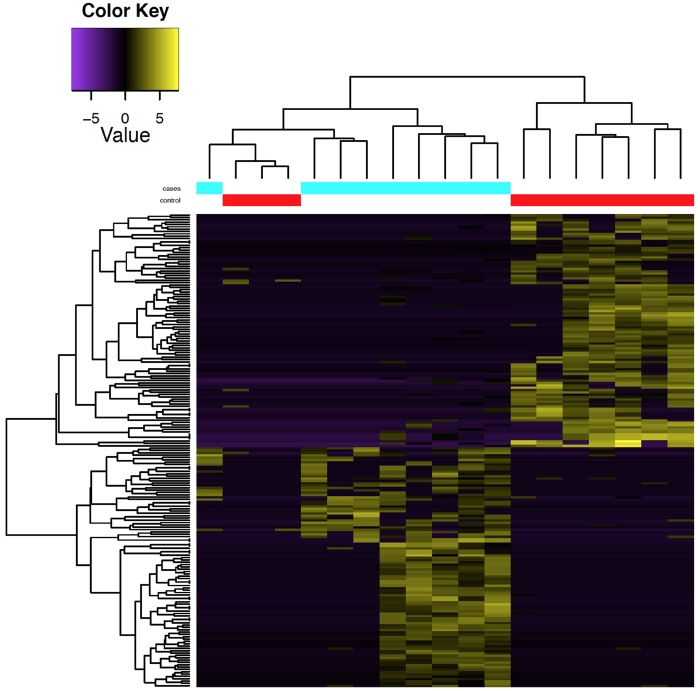
TE transcriptome in the DLPFC of Schizophrenia patients. The heatmap presents the pattern of the 112 up- and down-regulated TEs with Fold Change ± 4 comparing schizophrenic patients with controls. The vertical tree shows the distribution of schizophrenic patients (blue line) and controls (red line). The horizontal tree shows the distribution of the 112 expressed TEs and the colors in the body of the graph show which TEs are over- (yellow) or underexpressed (purple). The list of the up and down-regulated TEs used to build the graph are reported in supplementary table 5, Supplementary Material online.